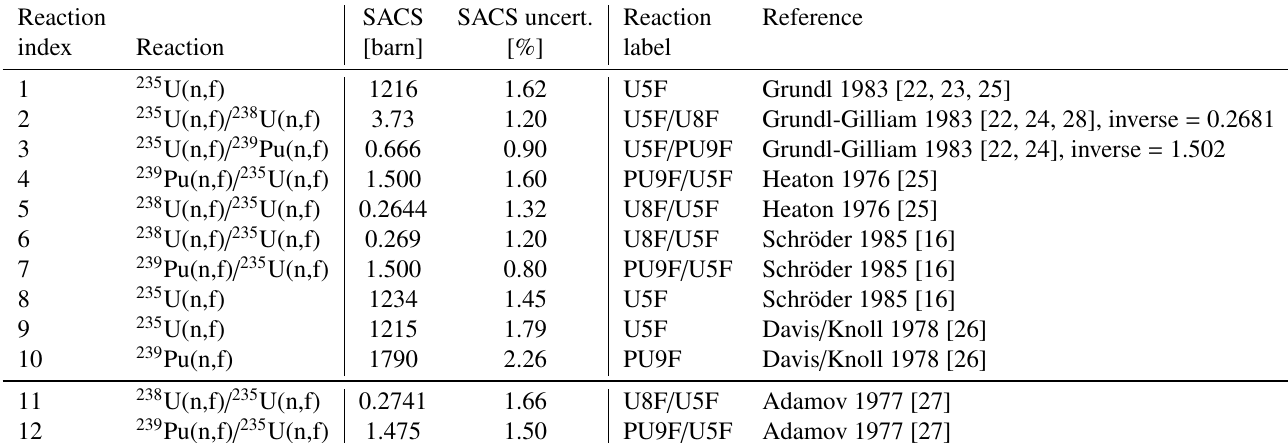
Table 5: Experimental 235 U(n,f), 238 U(n,f), and 239 Pu(n,f) SACS in 252 Cf(sf) neutron spectrum: updated database. Reaction